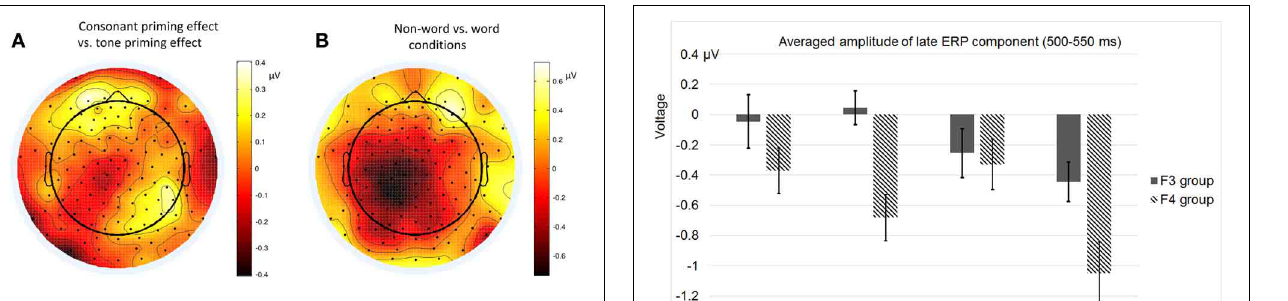
FIGURE 8 | Topographies of P2 (200–220ms) contrasts in different conditions of Experiment 2. (A) Consonant priming effect vs. tone priming effect; (B) Non-word vs. word condition.